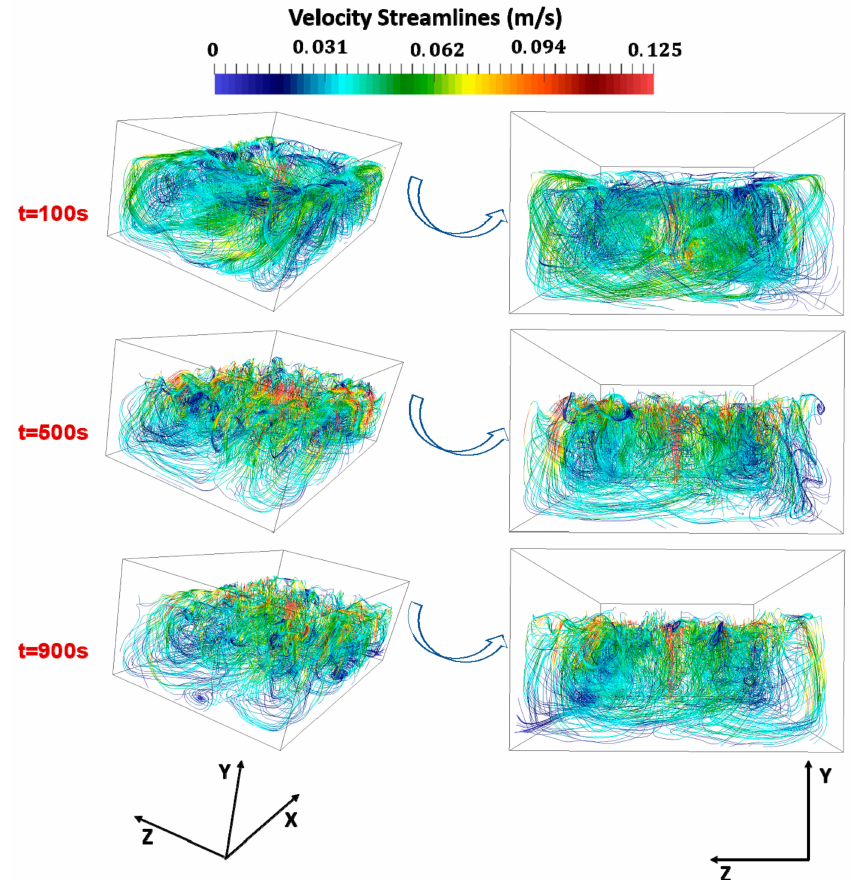
Figure 5. Stream traces of the fuel for a single inlet at three different times. The left column shows a perspective view of the fuel tank and the right column shows a view along width of the